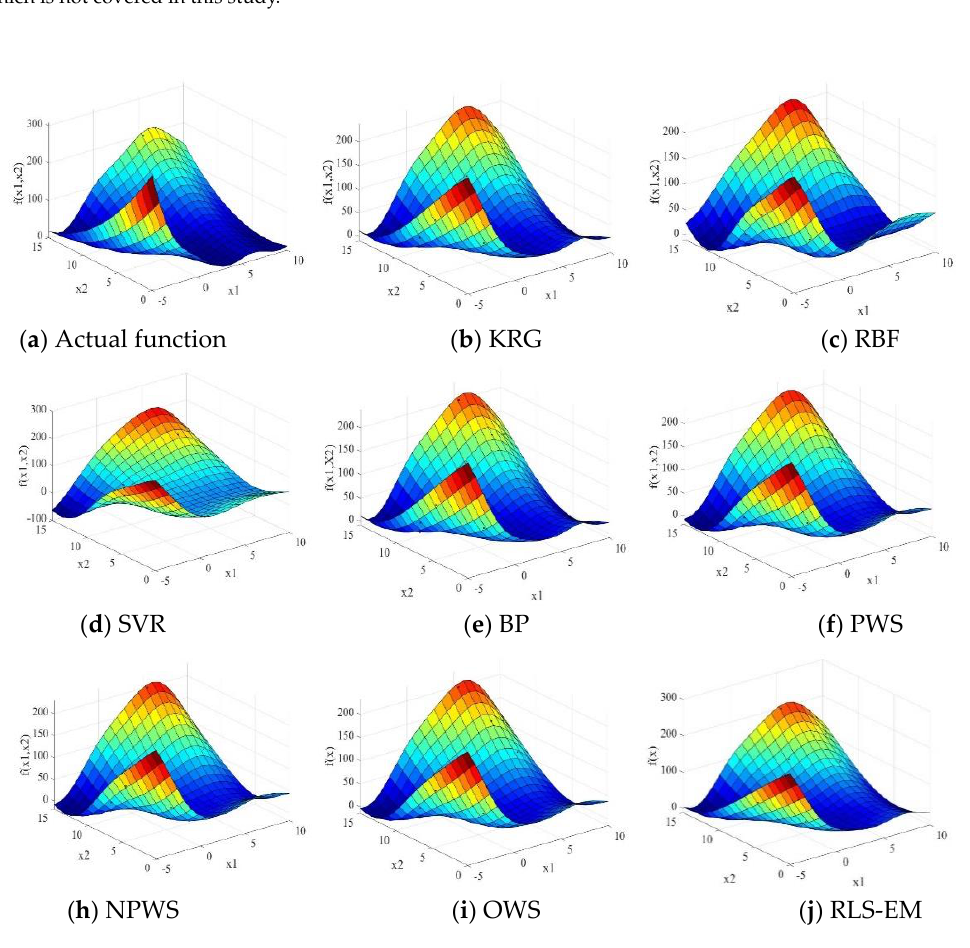
( j ) RLS-EM Figure 2. Surface plots of the Camelback function.